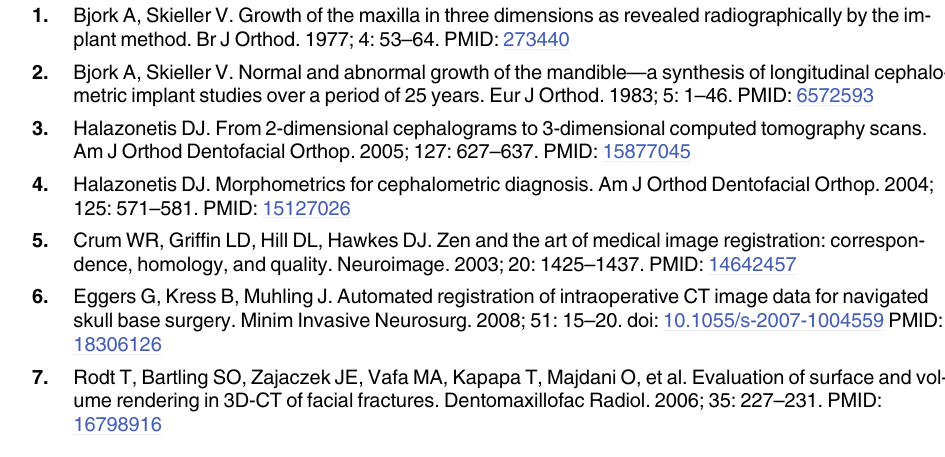
S2 Table. Non parametric MANOVA on accuracy measurements (deviation between struc- tures). Three crossed factors and their possible interactions were analyzed: superimposition technique (fixed factor; 5 techniques), operator (random factor; 3 operators), and time (fixed factor; 2 time points). Data were transformed to fourth-root. Analysis was based on Bray-Cur- tis distances. Permutation of residuals under the reduced model was performed. No. of permu- tations used = 9999. R2 = 0.61%. S3 Table. Inter-operator reliability of each superimposition technique. This was calculated for the distances (x, y, z, D) between the two serial datasets (T0, T1) at 4 specific points, measured by each operator in each patient (n = 8 patients x 4 points x 4 values for each point = 128; significance level 0.01; Pearson ’ s correlation). From this analysis, it can be concluded that inter-operator reliabili- ty was high for the 3-point registration technique and excellent for the other four techniques. S4 Table. Overall distance (D) of two serial datasets at four specific points. These distances were measured by each operator following each superimposition technique (n = 8 patients x 1 point x 1 value = 8; significance level 0.01). The generalized linear model with repeated mea- sures was used for comparisons. From this analysis, it can be concluded that the precision of all registration techniques was high since no significant differences were detected between opera- tors on directly measured structural changes on the superimposed models, at four pre-defined points, concerning each one of the superimposition